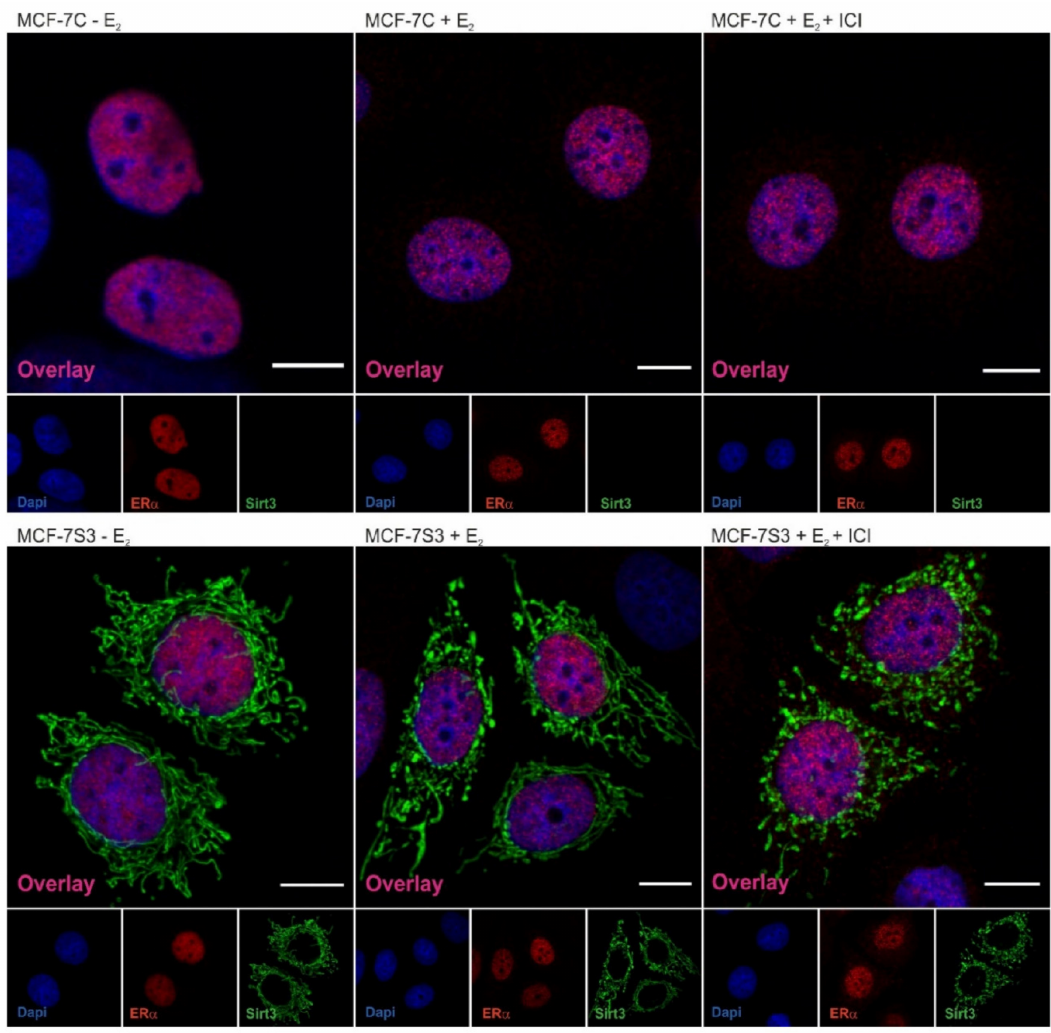
Figure 2. Sirt3 does not colocalize with ER α in MCF-7 cells. Confocal imaging of ER α localization in control, E2, and E2 + ICI-treated MCF-7C and MCF-7S3 cells. Bar represents 10 µ